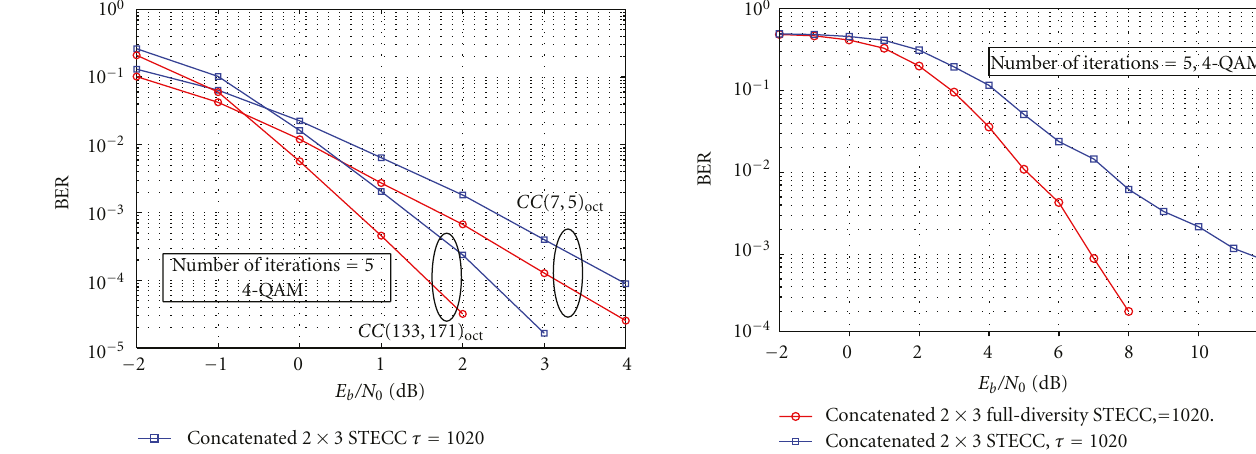
Figure 7: Performance comparison of the concatenated full diver- sity STECC and the concatenated STECC. 3 × 4074 informationbits. n